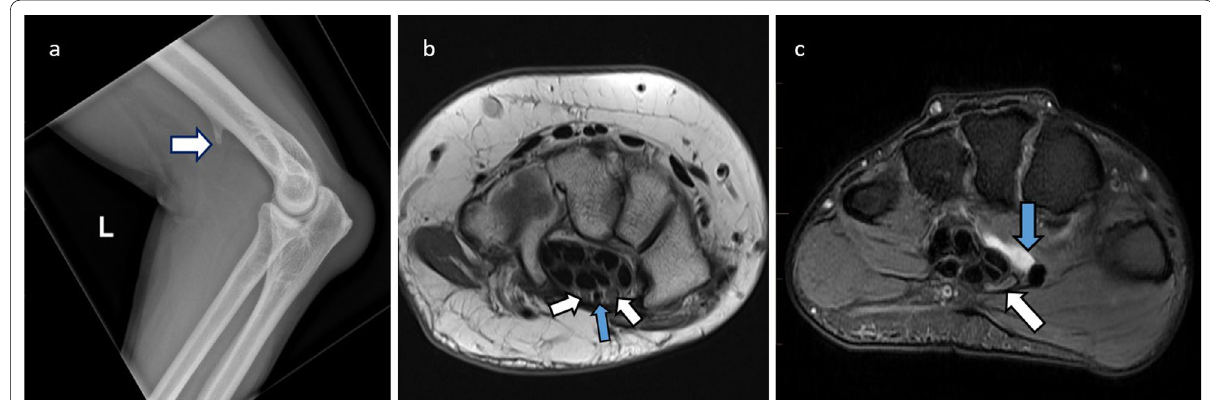
Fig. 11 Causes of median nerve entrapment are illustrated. a : 56-year-old male with supracondylar spur seen on lateral elbow X-ray (white arrow). This is a known risk factor for median nerve impingement at the ligament of Struthers. b : Axial PD of 50-year-old female with carpal tunnel syndrome proven on electrophysiology. There is a congenital variant of bifid median nerve (white arrows) with persistent median artery (blue arrow) which can predispose to carpal tunnel syndrome. c : 30-year-old female with carpal tunnel syndrome. This patient has a ganglion (blue arrow) that is encroaching on the carpal tunnel. There is indentation of the median nerve with a width/height ratio of more than 3 (white arrow)